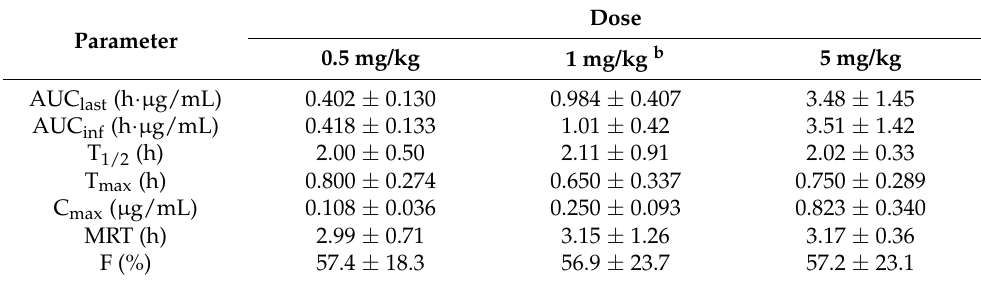
Figure 2. Pharmacokinetic profile of supinoxin following the oral administration of 0.5, 1, and 5 mg/kg in rats. Each point represents the mean ± standard deviation ( n = 4–5). Table 2. Pharmacokinetic parameters of supinoxin after oral administration a .